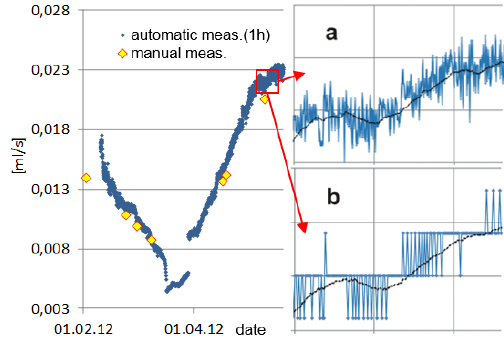
Fig. 8. Dripping seepage V2 – discharge level progression with detailed part of the course for two di ff erent record regimes of the tipping bucket (a – every tipping time; b – number of tips per 1 h). Daily floating averages (black lines) are rather similar.